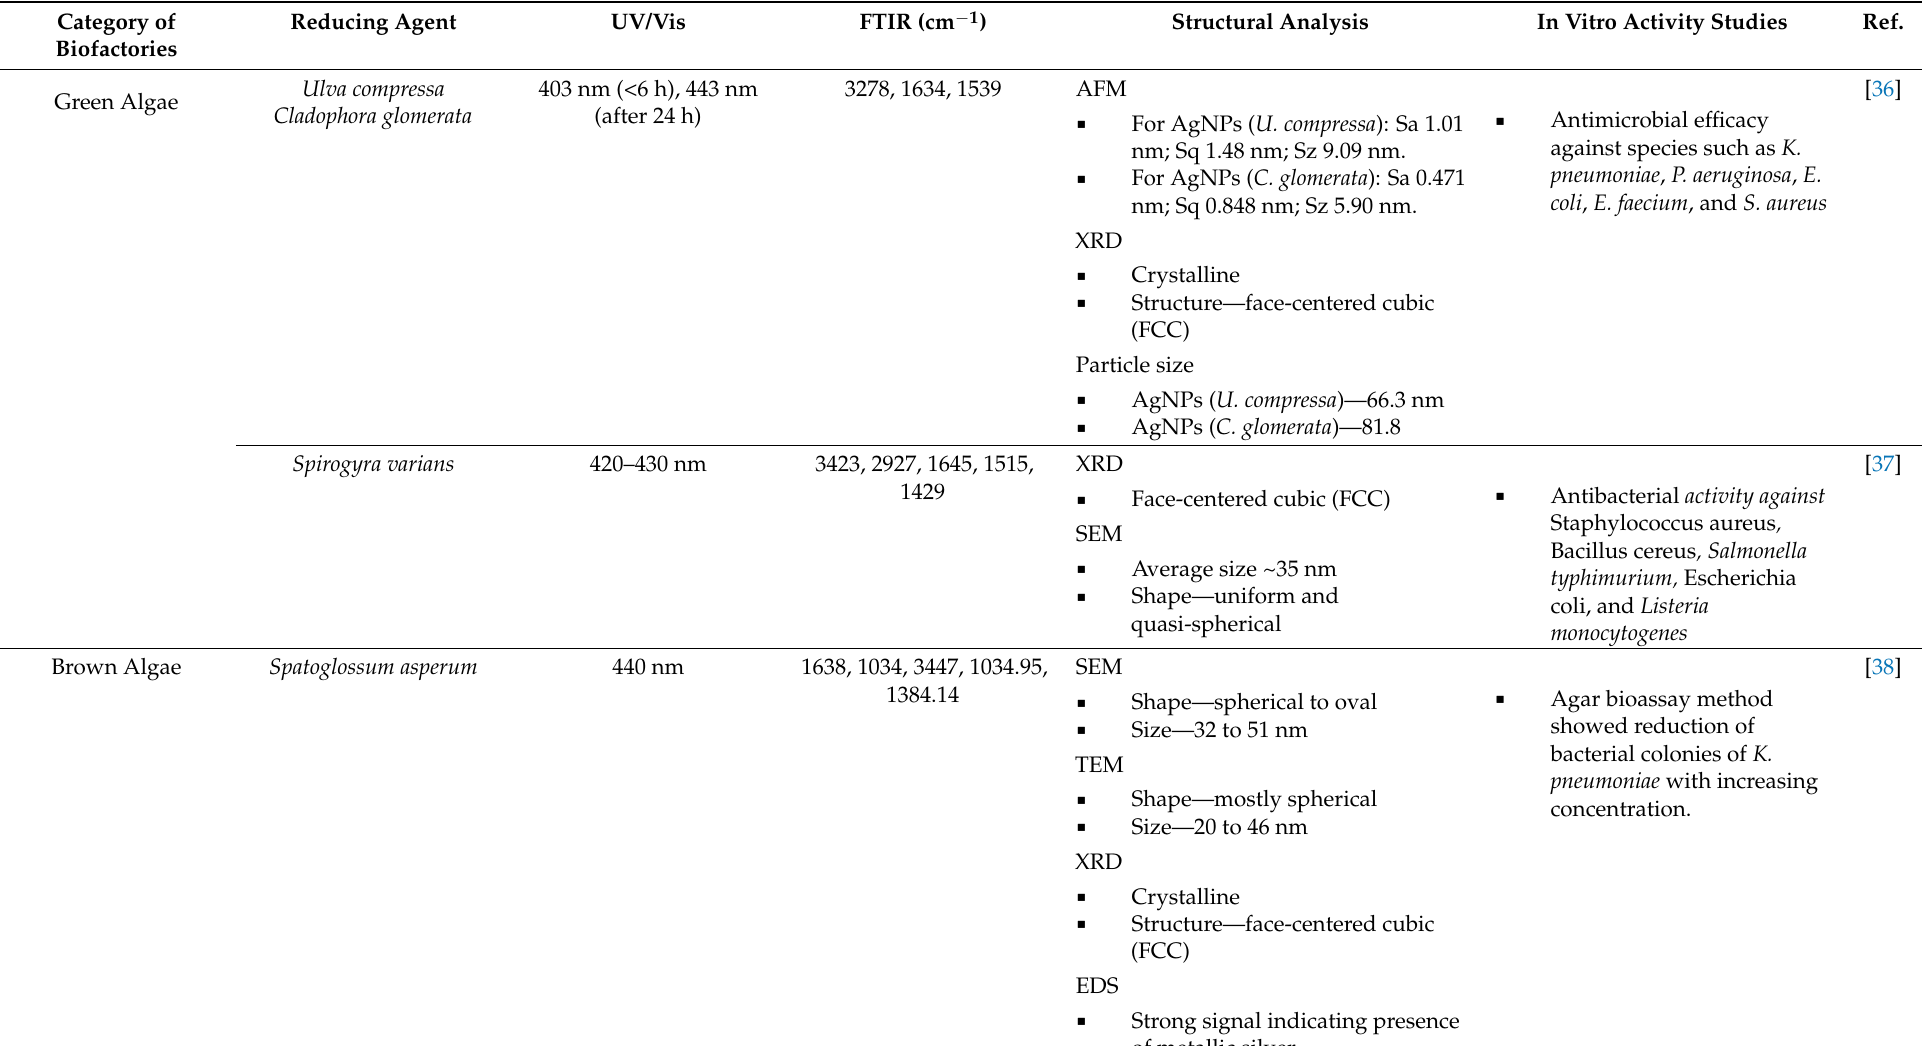
Table 1. Use of bionanofactories in the synthesis of silver nanoparticles, along with a brief outline of their physicochemical and antimicrobial properties. Category